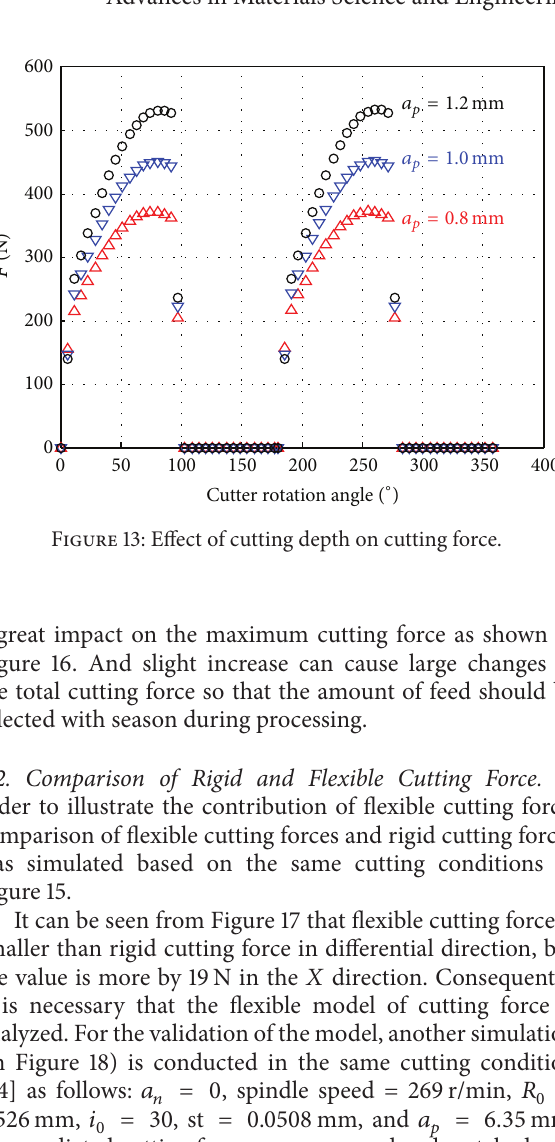
Figure 12: Effect of tooth number on cutting force.